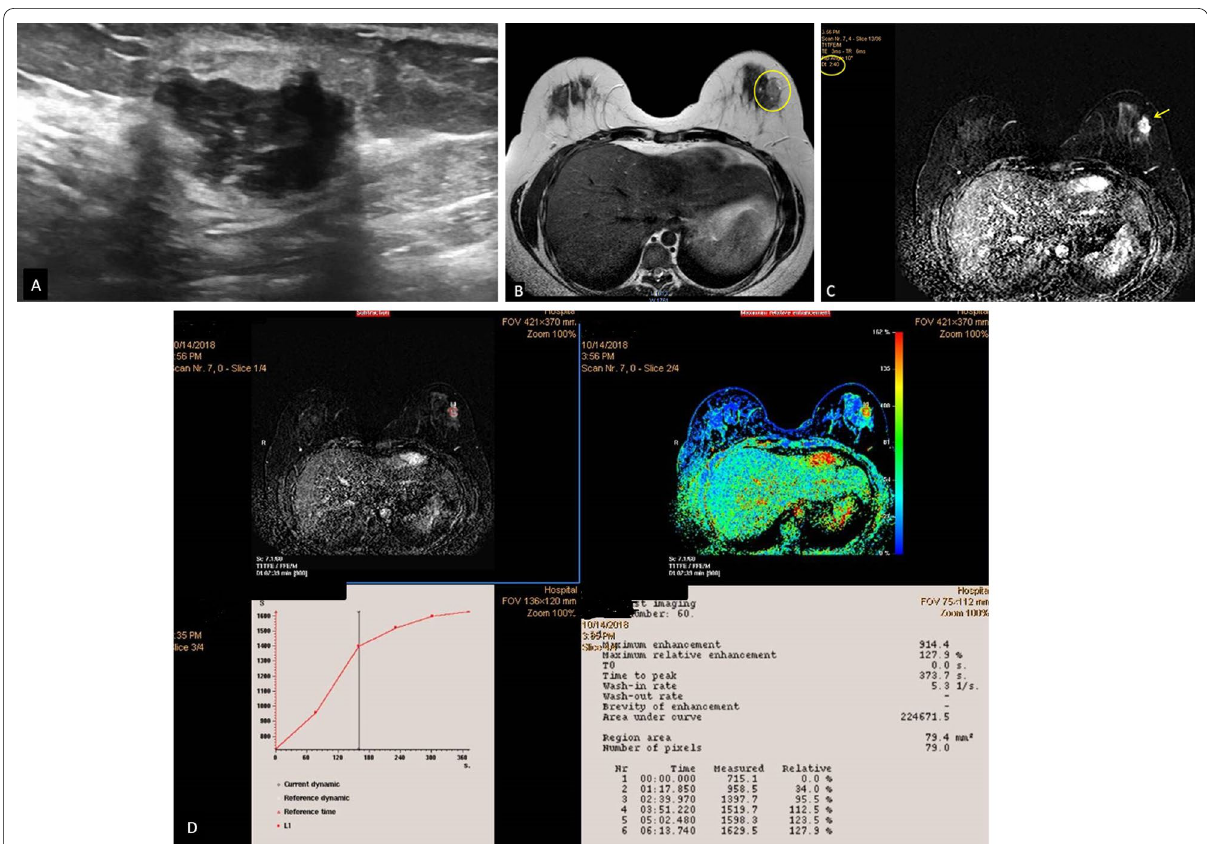
Fig. 1 Young patient, high risk, 31 years old. a Ultrasound gray scale image that displayed an oval-shaped solid mass with suspicious infiltrative presentation and irregular borders and accordingly was given as BI-RADS 4 category. b Pre-contrast T2-weigthed MR image that displayed lower outer solid breast mass (circle). c Post-contrast subtraction image (taken at 2 min.40 s, post-injection of contrast, circle) that showed suspicious early and heterogeneous contrast uptake of the left breast mass (arrow). According to the morphology descriptors of the MR images, the mass was irregular and showed intense contrast uptake; these criteria rendered the mass to be suspicious of malignancy (BI-RADS 4) and biopsy was requested. d The time/signal intensity curve showed type I pattern presented with early peak of the contrast uptake with a corresponding high signal intensity percentage of 96%. Examination of the removed specimen after surgery revealed an intracanalicular fibroadenoma surrounded